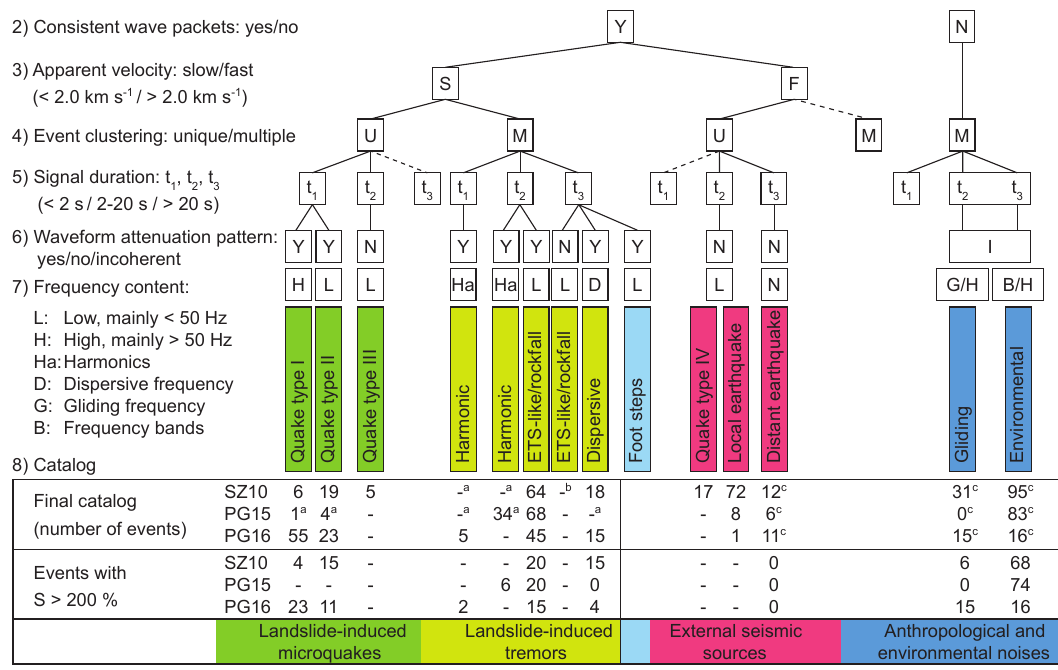
Figure 14. (1–7) Final decision-tree for microseismic event classification at clayey landslides. (8) Catalog with number of detection for each class (top frame) and number of near-source area events with S > 200% (bottom frame). Indices indicate (a) fields in which such events were detected, but recorded at less than three seismic stations; (b) fields were such events were observed by other fields campaigns (e.g., Walter et al., 2012); and (c) fields unrelated to the landslide microseismicity, where only the higher SNR events were catalogued. Discussion is found in Sect.